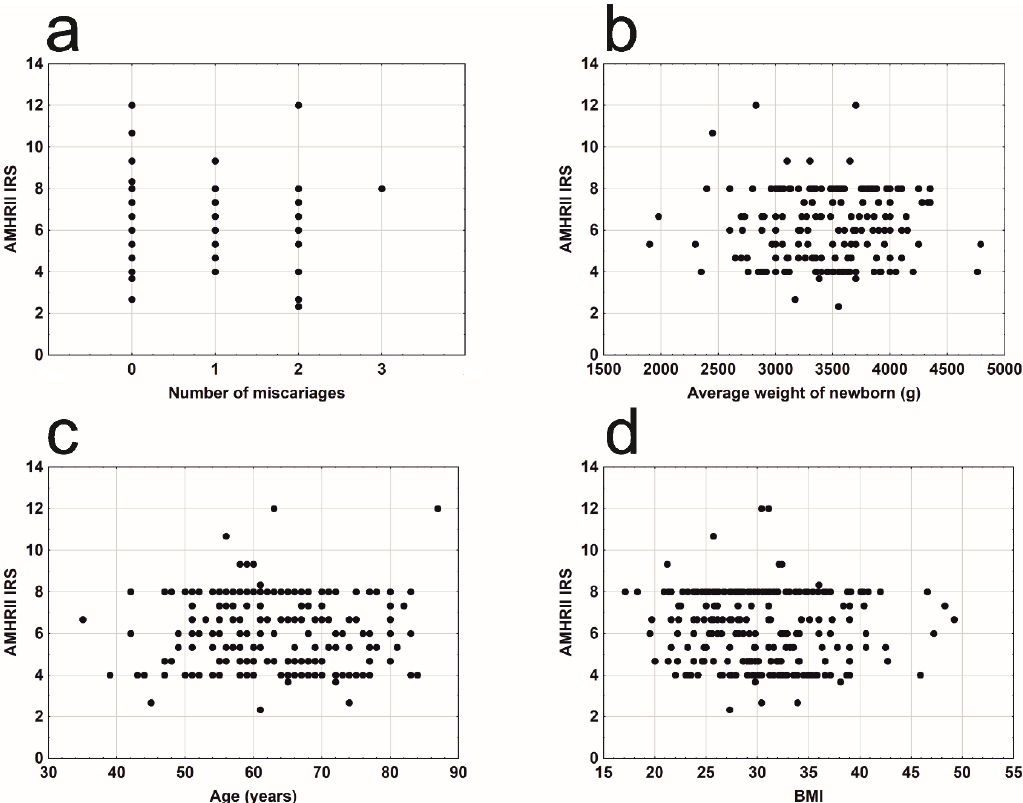
Figure 4. Mean AMHRII expression due to: ( a ) number of miscarriages (r γ = −0 .127, n = 230, p = 0.123); ( b ) average weight of newborn (s) (r s = 0.102, n = 206, p = 0.146); ( c ) age of the patient (r s = −0.002, n = 230, p = 0.980); ( d ) BMI (r s = −0.088, n = 230, p = 0.183).